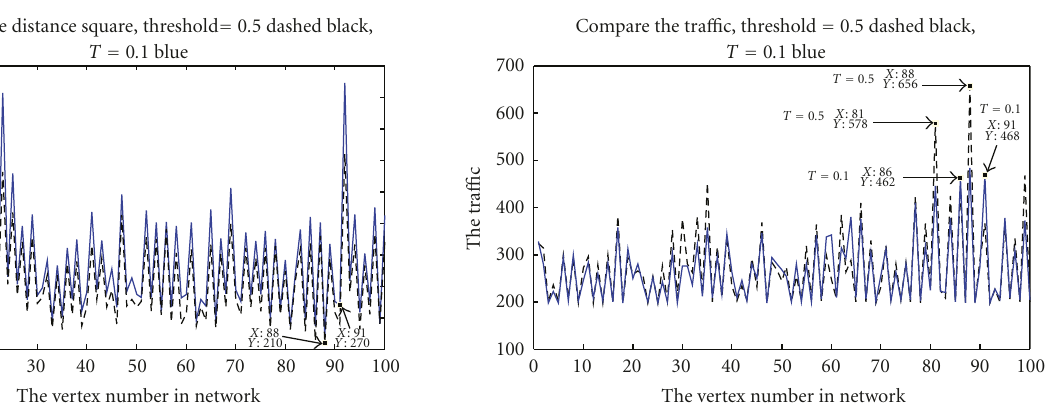
Figure 22: Tra ffi c with threshold 0.1 (solid blue line, positive curvature) and threshold 0.5 (dashed black line, negative curvature) versus vertex index. Observe that the dashed black tra ffi c curve (negative curvature) has higher